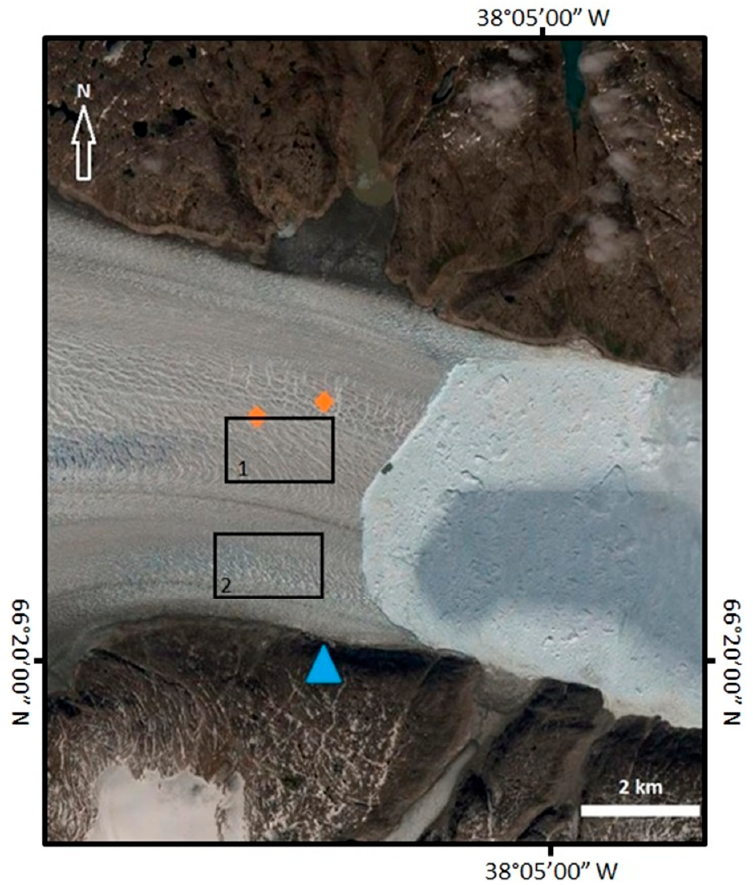
Figure 2. Helheim Glacier near the terminus. The blue triangle indicates the TLS scan position, the orange diamonds indicate the position of the two GPS units on the glacier surface during the TLS data collection, and black boxes indicate the bounds of study regions 1 and 2. The image was retrieved from the online Earth Explorer, courtesy of the NASA EOSDIS Land Processes Distributed Active Archive Center (LP DAAC), USGS/Earth Resources Observation and Science (EROS) Center, Sioux Falls, South Dakota, https://earthexplorer.usgs.gov/ .